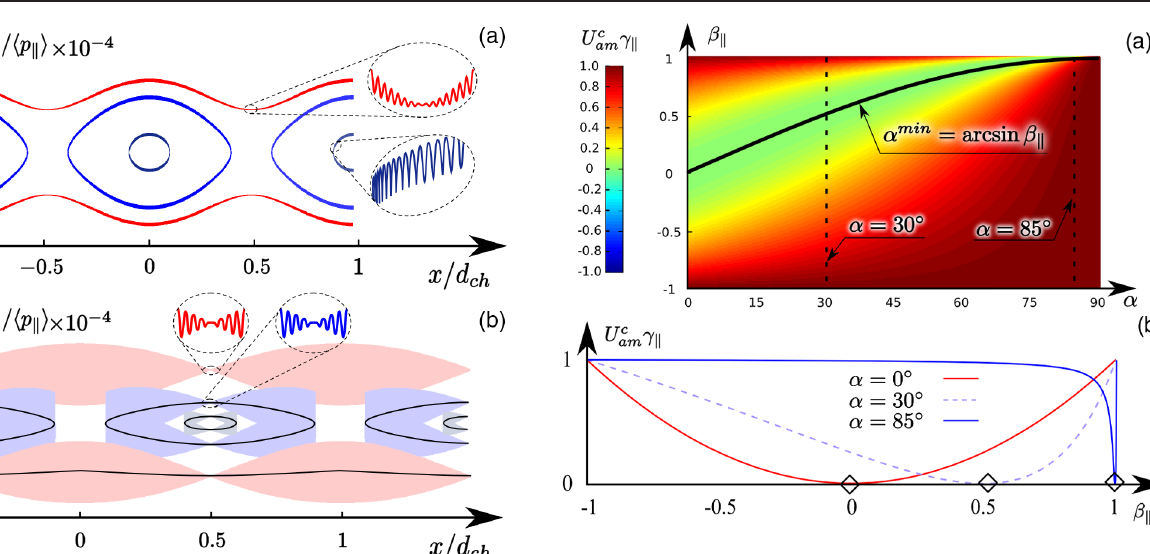
FIG. 4. (a) Normalized to unity potential amplitude U c a function of β ∥ and α for circularly polarized lasers case is shown. The amplitude of effective potential reaches minimal value equal zero on the curve α min ¼ arcsin β ∥ . (b) Normalized potential amplitudes for two circularly polarized laser beams, crossed at different angles. The values β min ¼ sin α are marked with diamond for each α